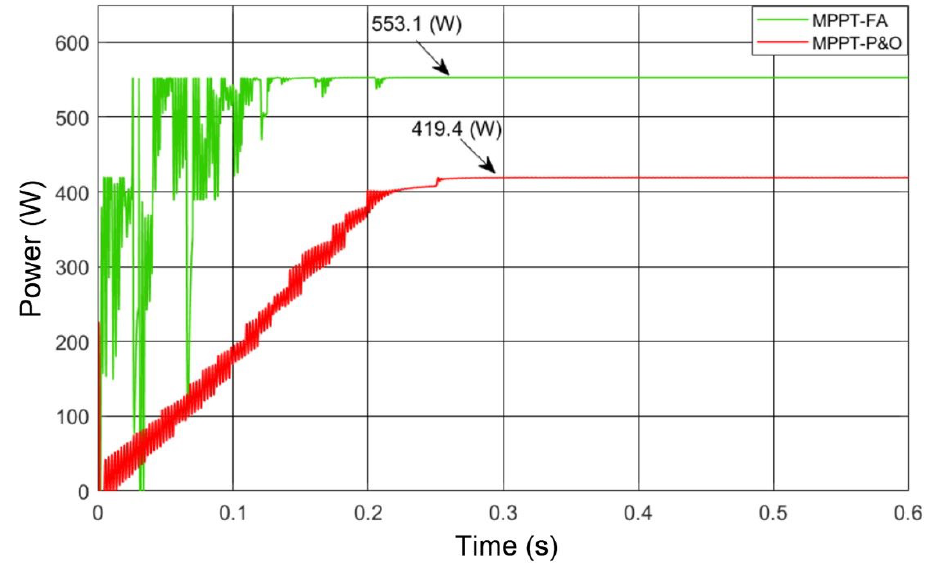
Figure 12. Simulation Results Step 2: Output Power P&O (419.4 W), Output Power FA (553.4 W).